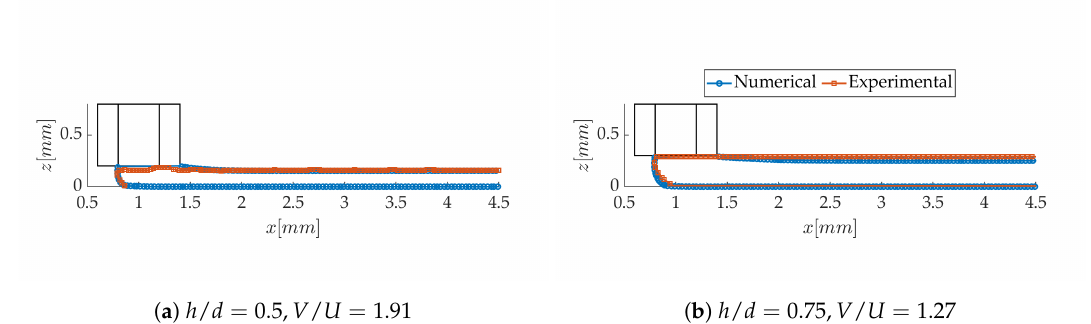
Figure 17. Comparison of numerical and experimental longitudinal strand shapes in liquid phase. The experimental contours are derived from the procedure described in Section